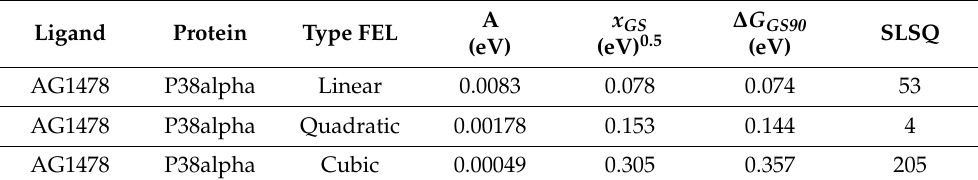
Table 2. Fit parameters for REES curve according to different thermodynamic models. (SLSQ refers to the sum of least-squares, a measure of the quality of the model fit to the